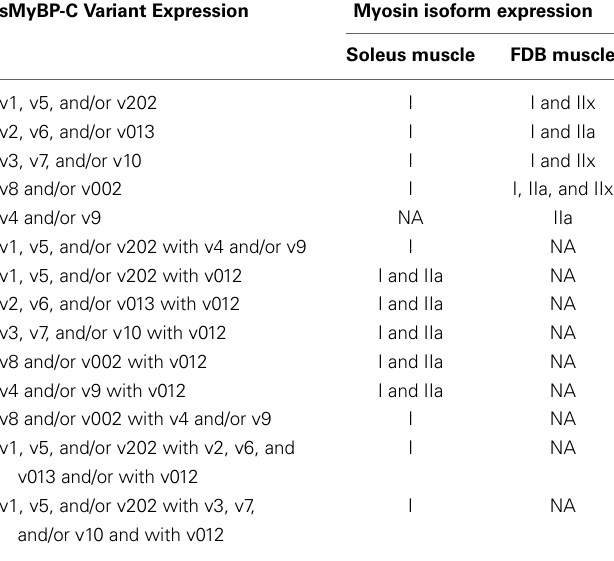
Table 3 | Correlation of sMyBP-C variant and myosin isoform